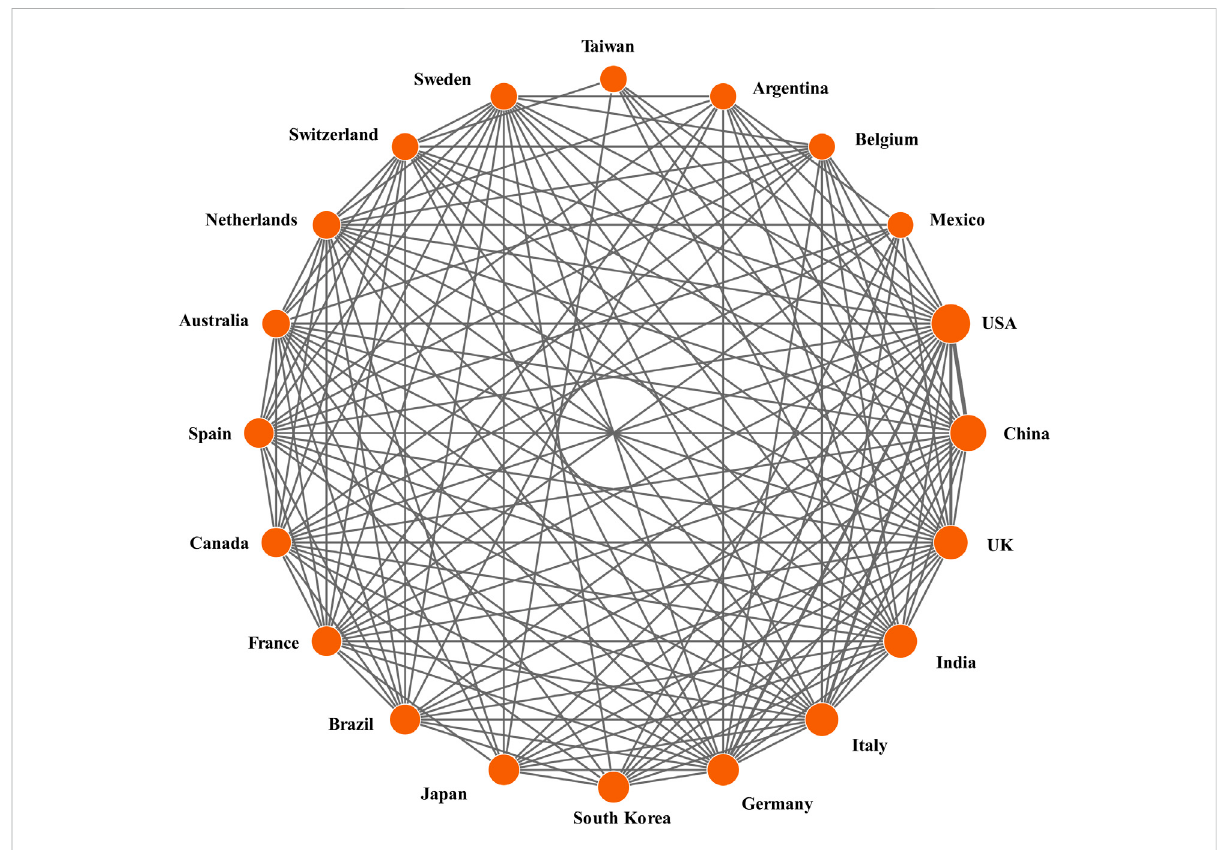
FIGURE 3 Cooperation between the top 20 most ef fi cient